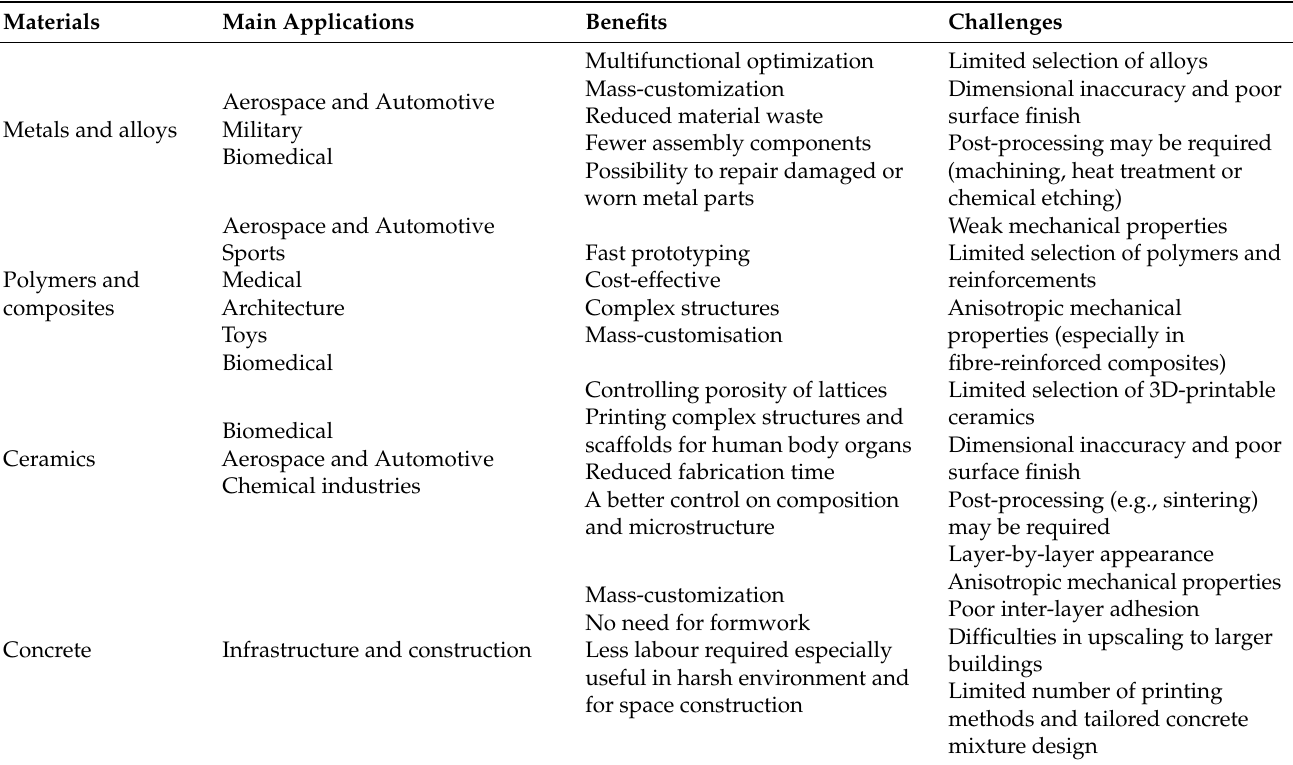
Table 2. A comparison of the materials used in 3D/4D printing, their applications, benefits, and challenges